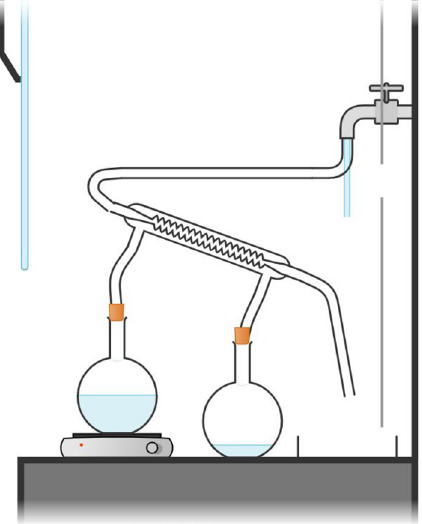
Fig. 1 Schematic of enclosed system set up, detailing connections between the condenser and the two flasks